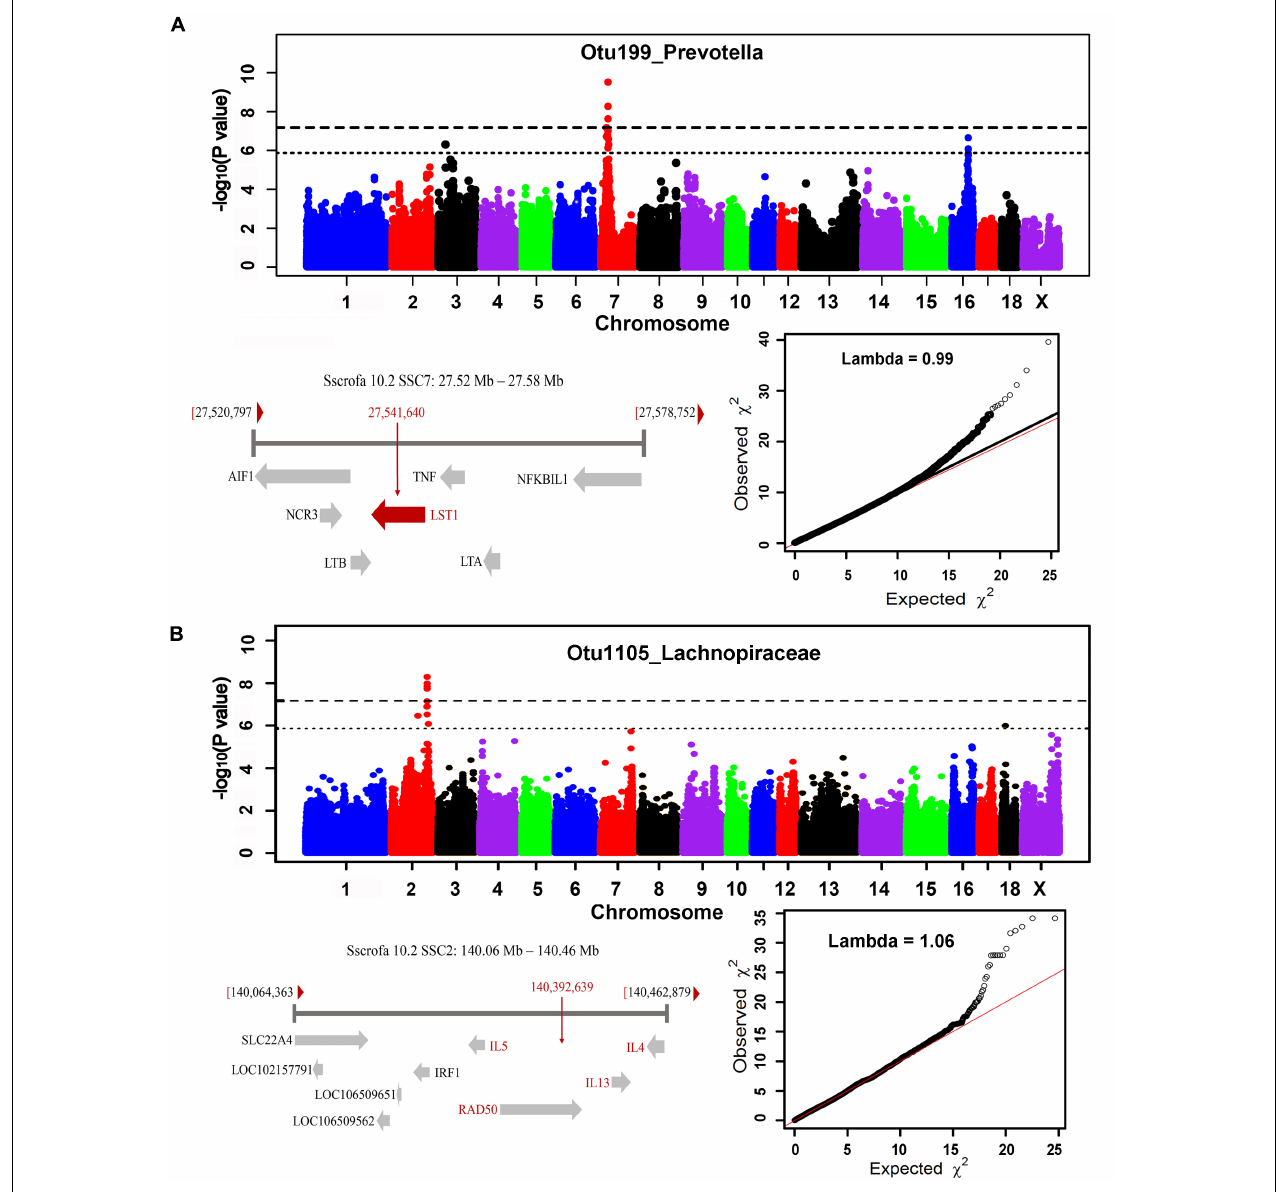
FIGURE 7 | MHC region on SSC7 (A) and interleukin gene family region on SSC2 (B) that were identified to associate Prevotella and Lachnospiraceae . For Manhattan plots, X-axis shows chromosomal positions. Y-axis shows –log10 P -values from GWAS. The horizontal dotted lines indicate the thresholds of genome-wide and suggestive significance level. The red horizontal arrow bar represents the closest